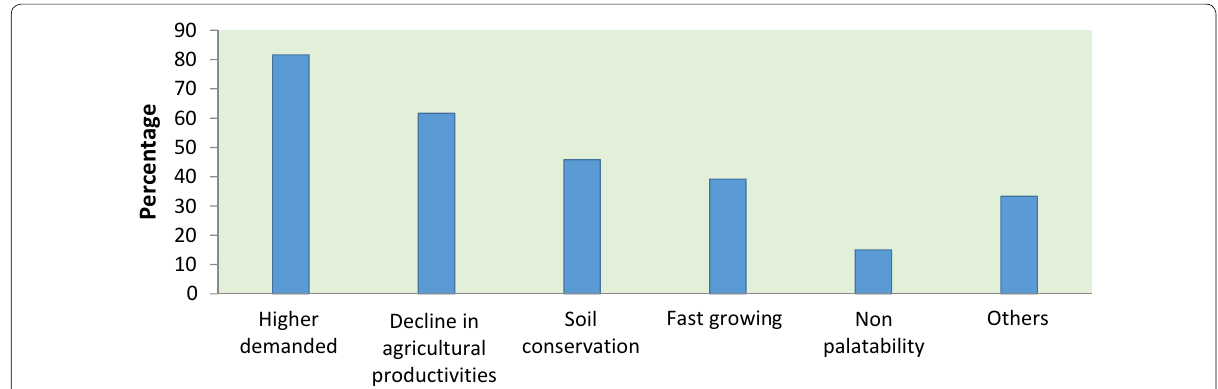
Fig. 2 Factors that motivate farmers to start Eucalyptus wood lot production (*Multiple responses)